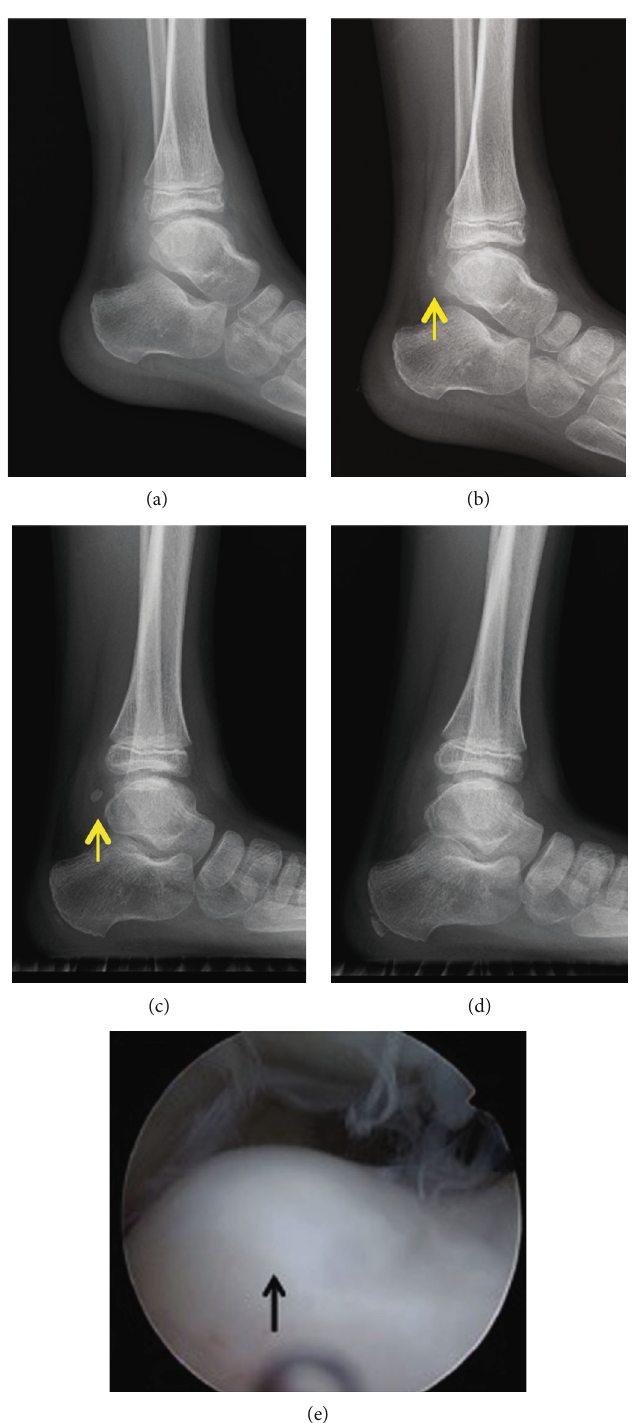
Figure 5: Chronological ankle lateral plain radiograph. (a) Postoperative three months after primary surgery, (b) postoperative fi ve months after primary surgery, (c) postoperative one year after primary surgery, and (d) postoperative six months after secondary surgery. (e) Arthroscopic fi ndings during secondary surgery. Gradual growth of a new oval ossi fi ed free body in the posterior joint space of his left ankle after primary surgery (yellow arrow) (a – c). No recurrence after secondary surgery after six months postoperatively (d). The cartilage defect due to resection of the protuberance from the talus, which was treated with microfracture technique during primary operation, was covered with healthy cartilage (black